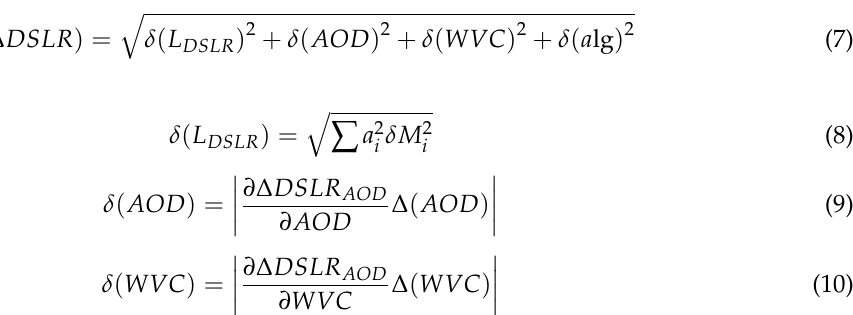
Figure 9. Comparisons of the actual downwelling surface longwave radiation with estimations using the proposed model for different surface types and VZA = 0, surface altitude z = 0 km and AOD = 0.5.